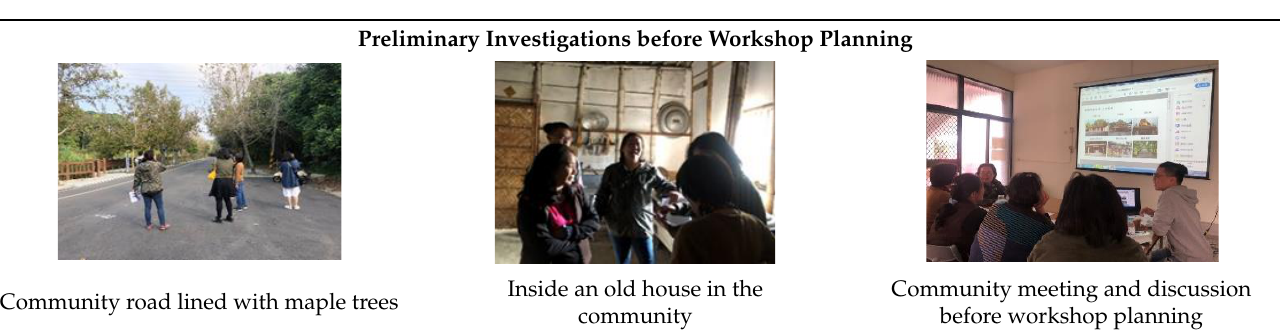
Table 4. On-site IEC workshop records.